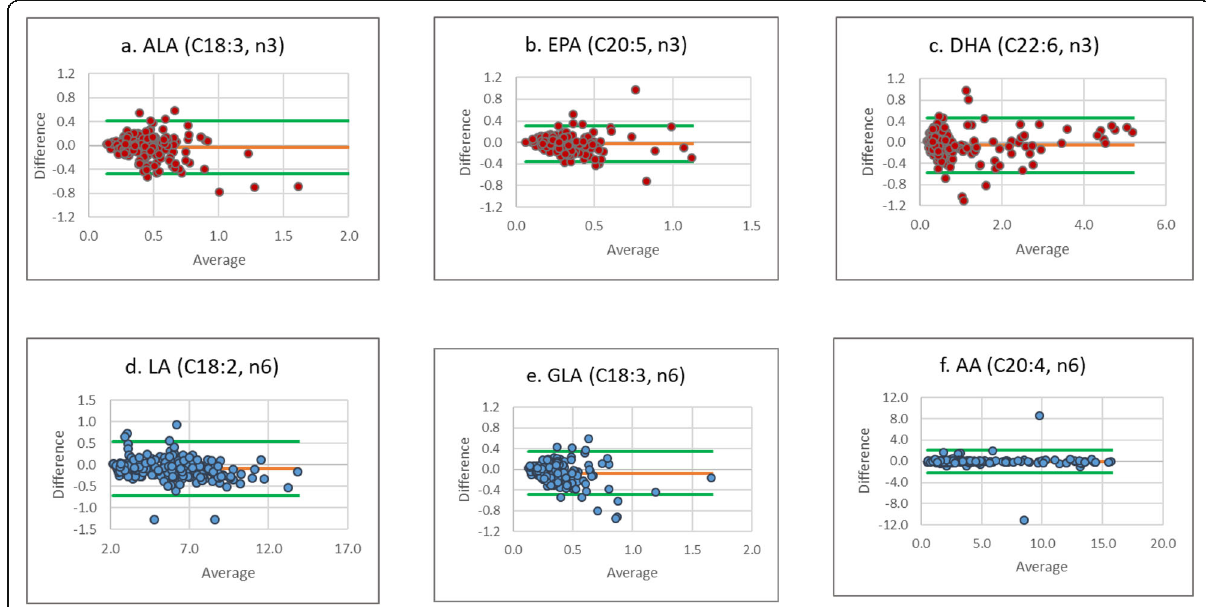
Fig. 2 Bland-Altman plot for fatty acids showing average value for the two laboratories versus difference of values between the two